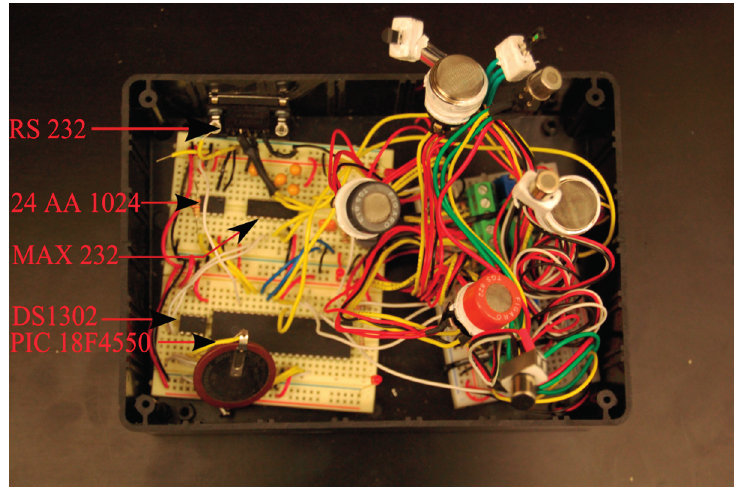
Figure 5. Top view of the electronic circuit designed for gas sensor